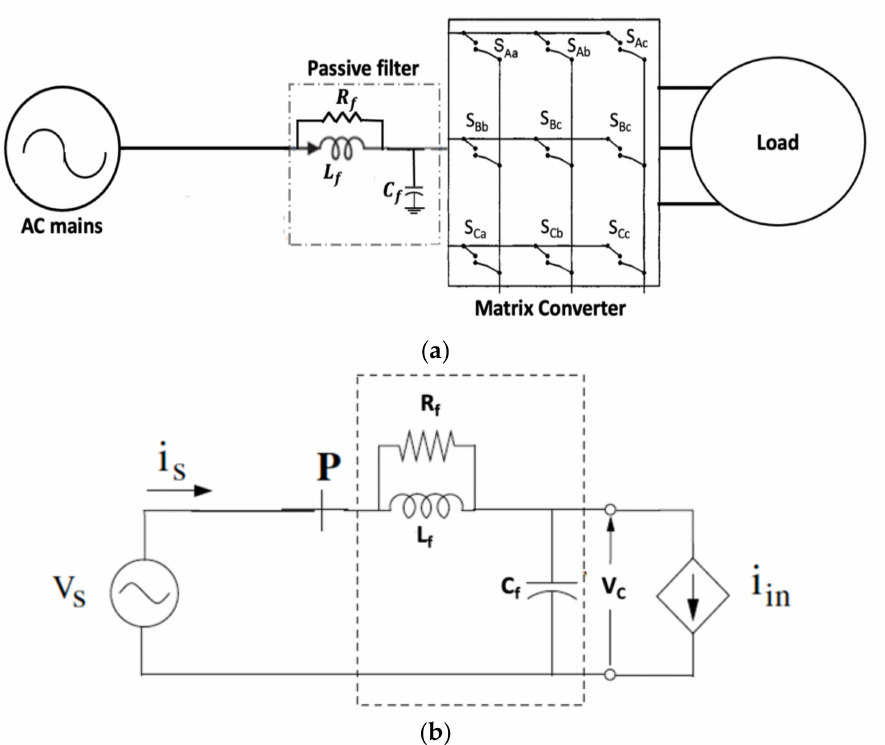
Figure 2. Passive LC filter for MC input harmonic mitigation: ( a ) single line diagram; ( b ) equivalent circuit